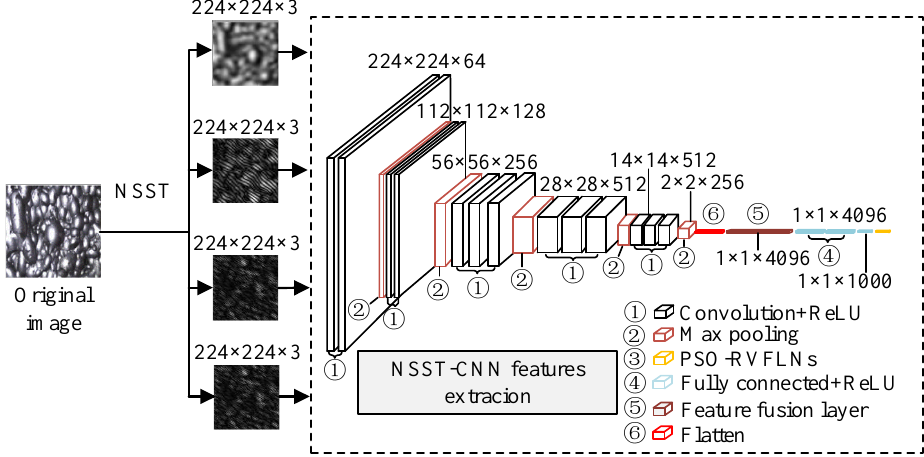
Figure 4. NSST-CNN network feature extraction model.